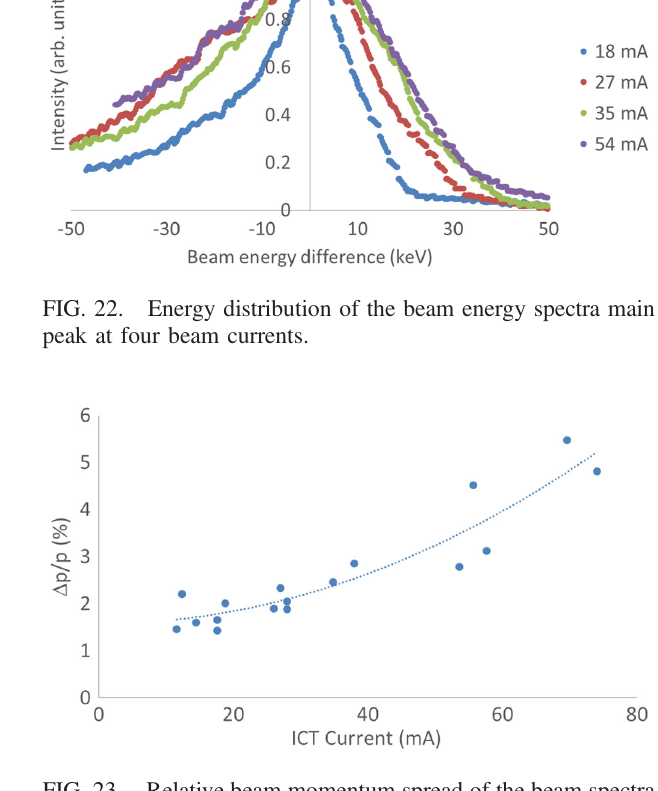
FIG. 20. Beam energy as a function of the linac rf power.